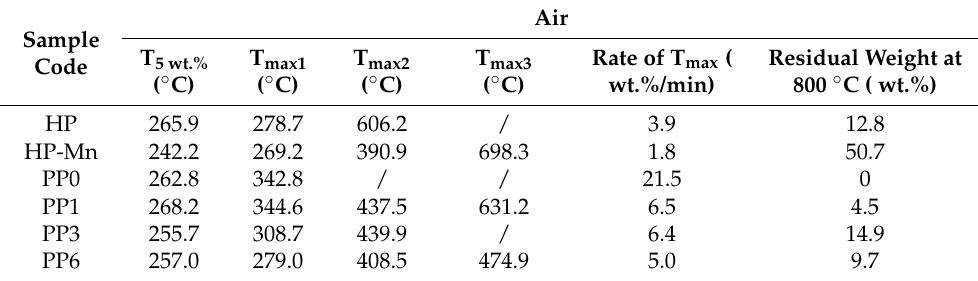
Table 5. TG and DTG curves of HP, HP-Mn, Pure PP and its flame-retardant composites under air